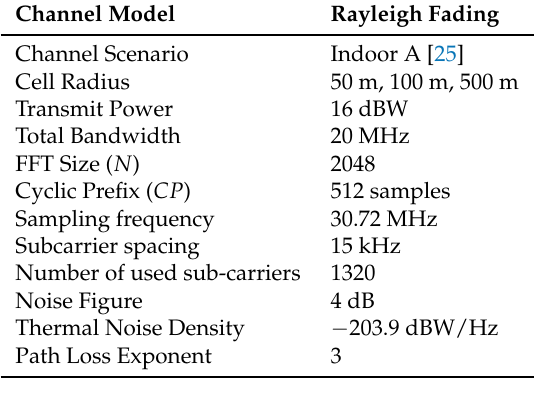
Table 2. Simulation Parameters.